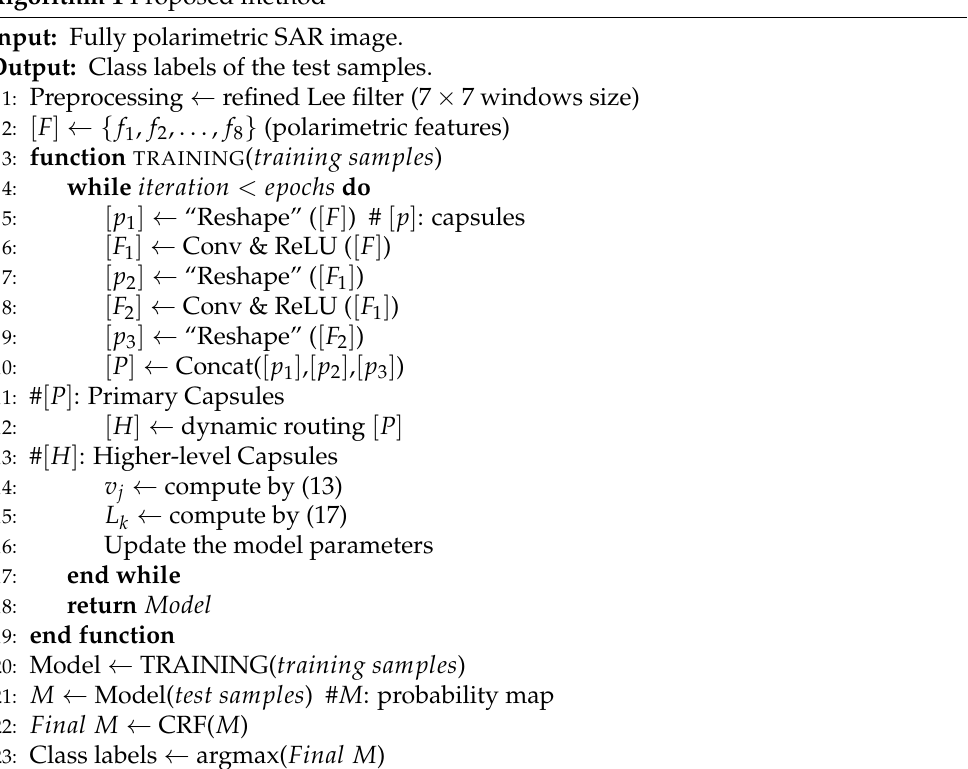
Algorithm 1 Proposed method